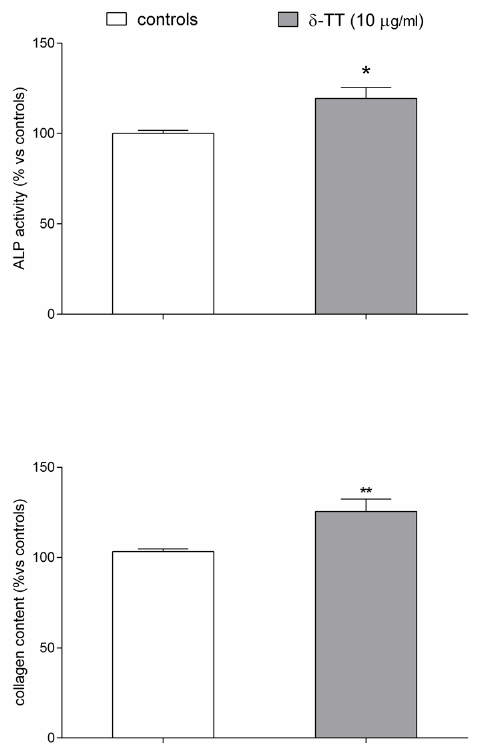
Figure 9. Effects of δ -TT (10 μ g/mL) on MC3T3-E1 differentiation. ALP activity and collagen content were evaluated in differentiated cells 48 h after treatment. Data are expressed as the percentage relative to control and are the mean ± SEM of six replications. * p < 0.05, ** p < 0.01 vs. controls.